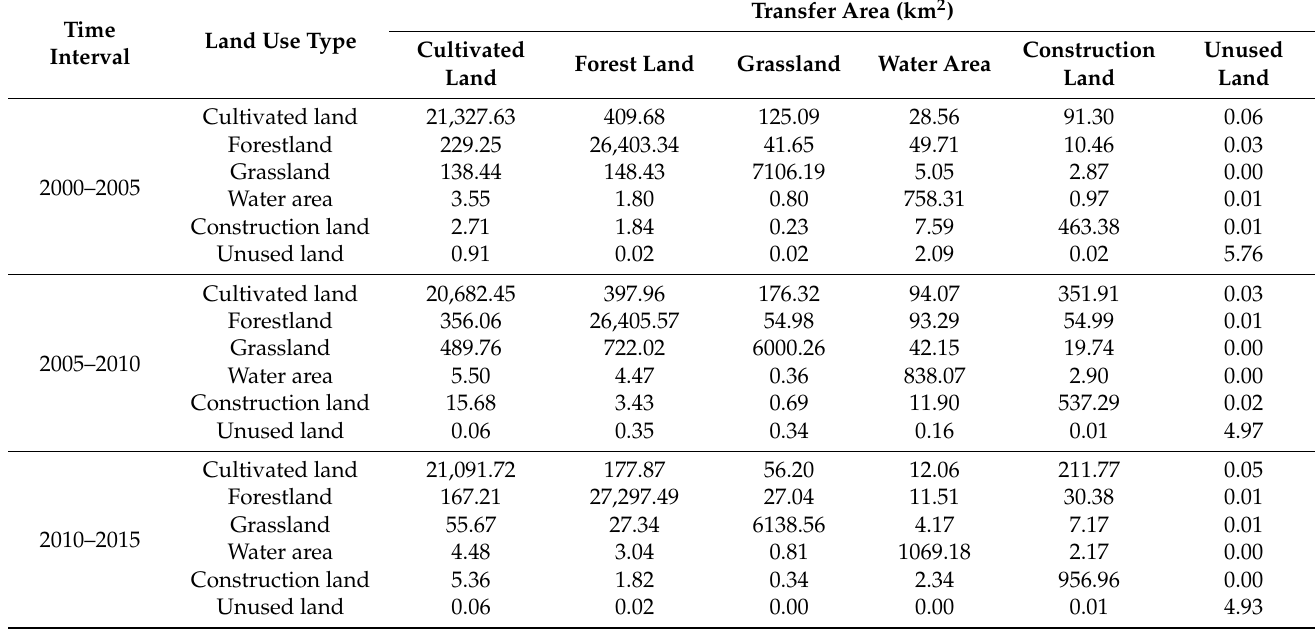
Table 4. Transfer area of land use types from 2000 to